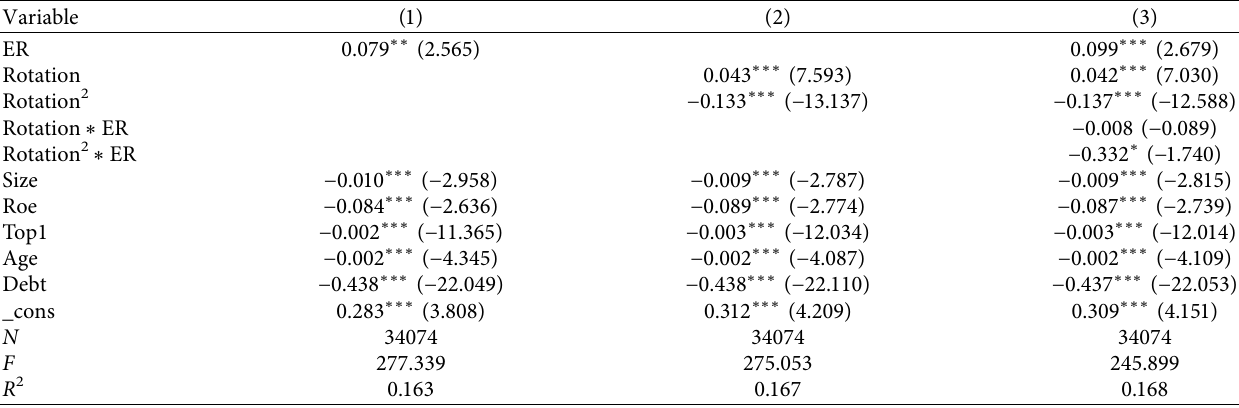
Table 9: Regression results of impact of environmental regulation and official communication on enterprises’ innovation capability.